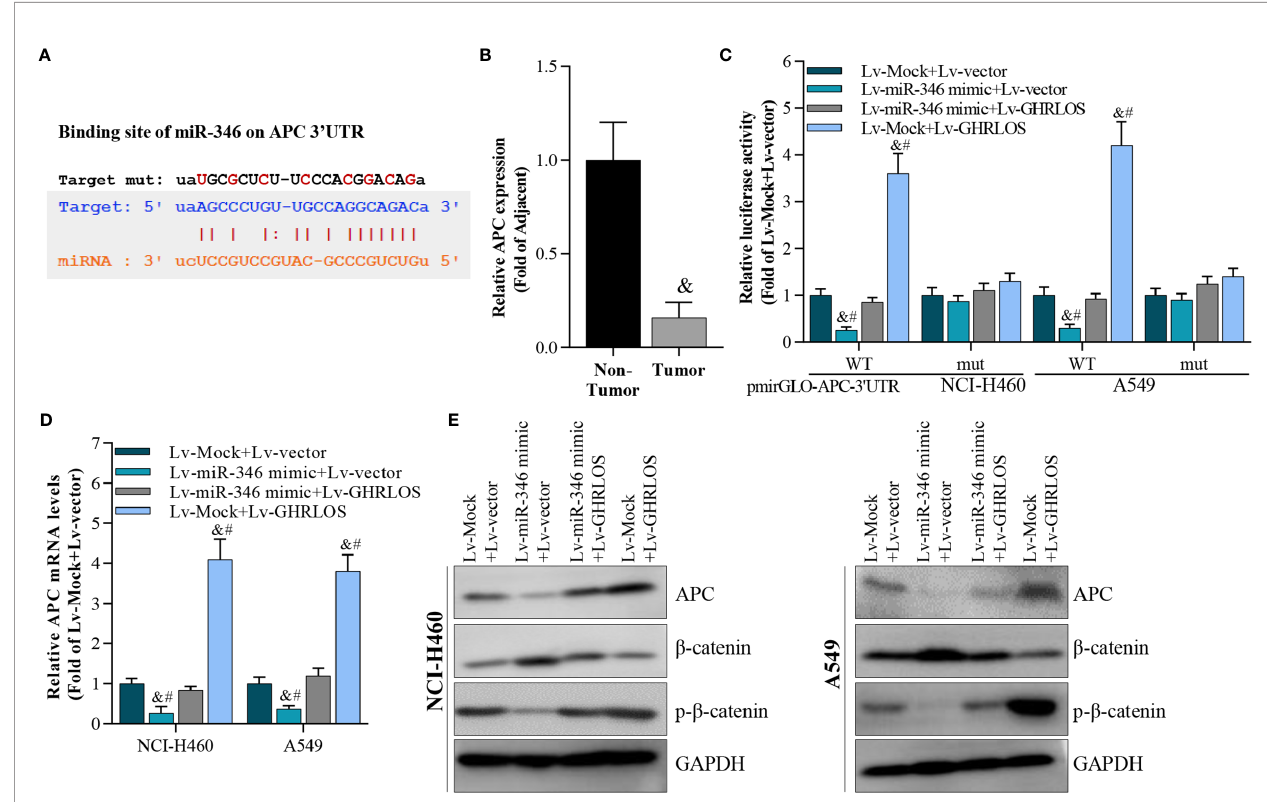
FIGURE 6 | APC was a target of miR-346 and regulated by interaction of lncRNA GHRLOS and miR-346. (A) Predicted binding site of miR-346 in the APC 3 ’ UTR (STARBASE database). (B) qRT-PCR analysis on APC expression in NSCLC tissues, &p< 0.01 vs. non-tumor. (C) Dual luciferase reporter assay on luciferase activity of APC 3 ’ UTR, &p< 0.01 vs. Lv-Mock+Lv-vector, #p< 0.01 vs. Lv-miR-346+Lv-GHRLOS. (D) qRT-PCR analysis on APC expression in cancer cells infected with lentivirus for 48 h, &p< 0.01 vs. Lv-Mock+Lv-vector, #p< 0.01 vs. Lv-miR-346+Lv-GHRLOS. (E) Western blot analysis on APC expression in cancer cells after lentivirus infection for 48